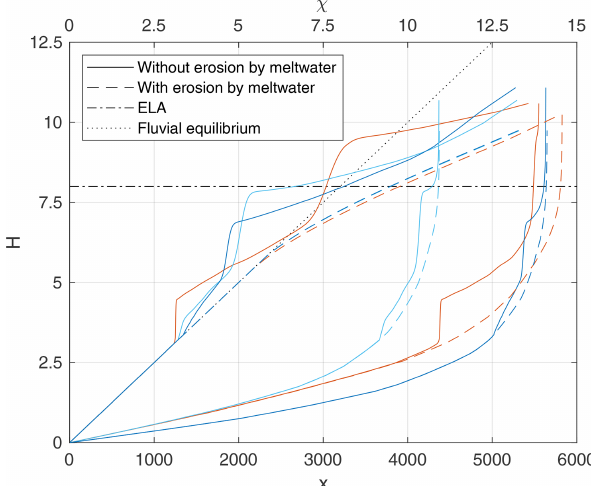
Figure 6. Total flux A and ice flux A i of the flow paths shown in Fig. 3 for H e = 8 and H f = 10, both expressed in terms of their catchment-size equivalent. The along-stream coordinate x starts from the boundary of the domain.